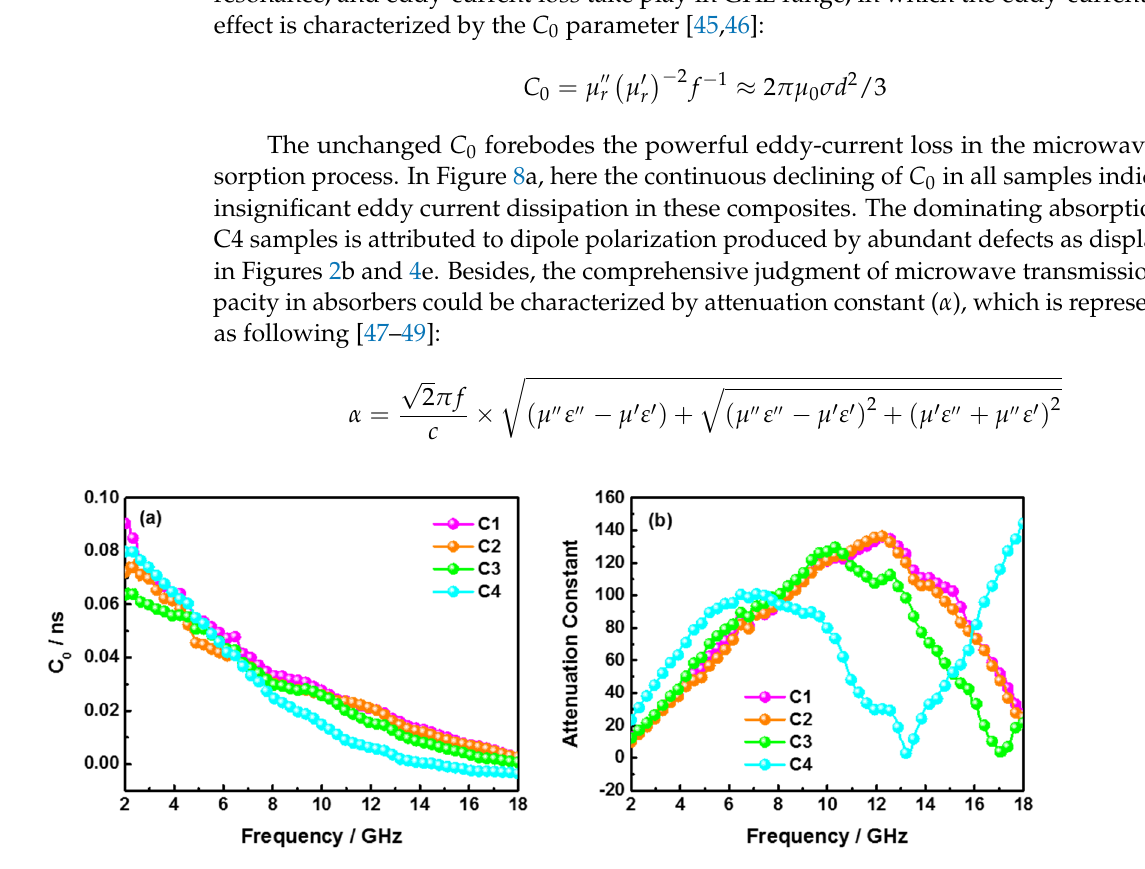
Figure 8. Parameter for eddy current effect ( a ) and attenuation constant ( b ) in C1–C4 composites. The larger α indicates a weaker transmission of microwave in composite.